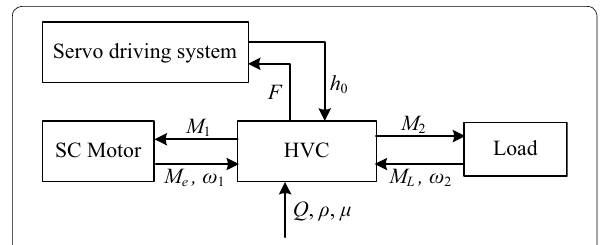
Figure 4 Parameter interrelations of cutter-head driving system Figure 5 Different variations of film thickness during